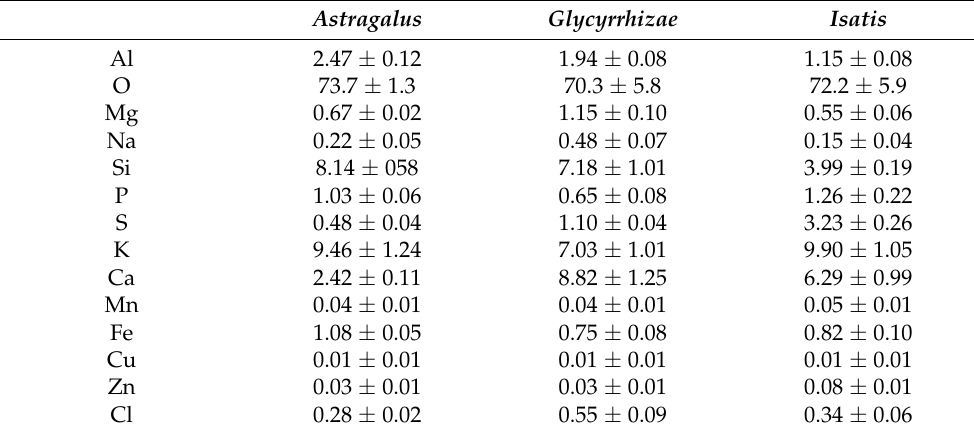
Table 2. Inorganic compositions of different CHMs (%).